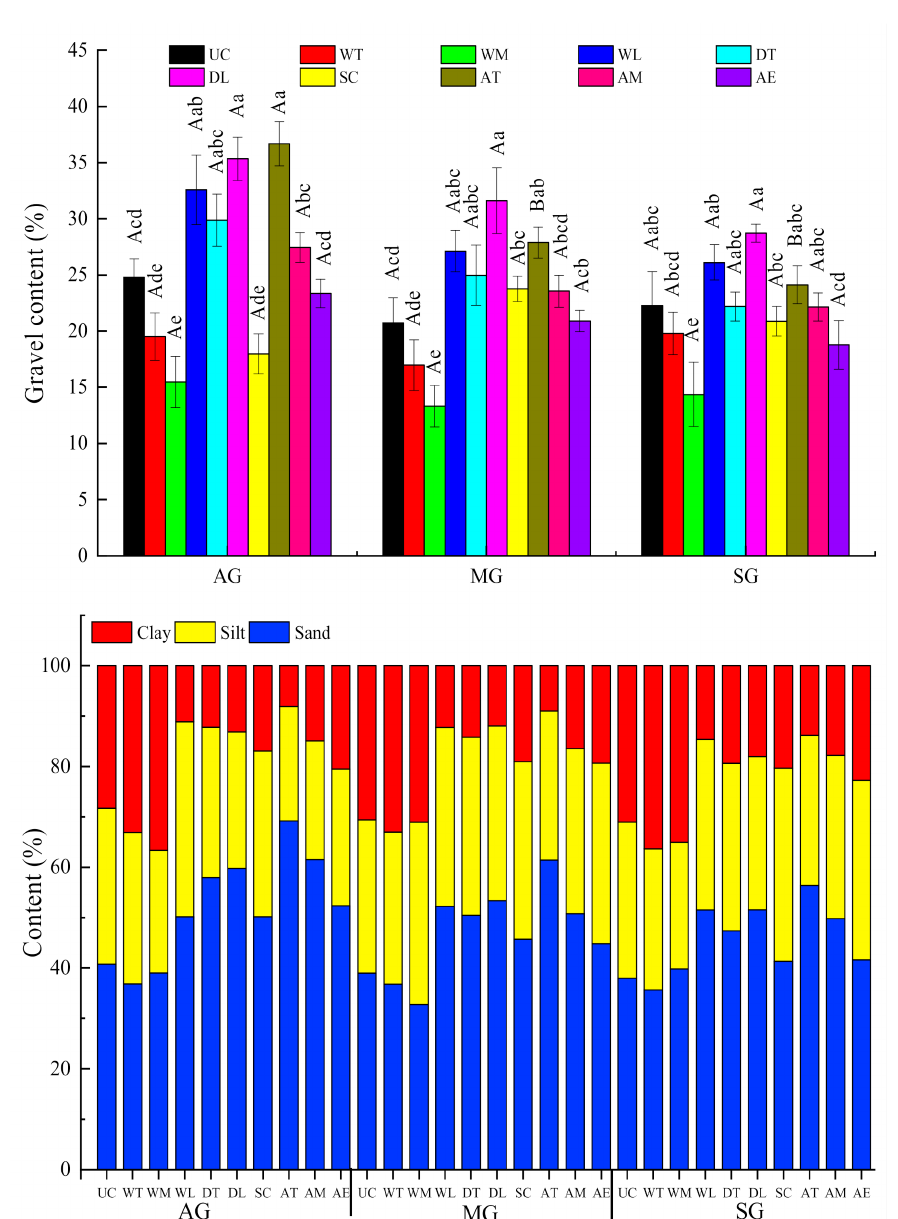
Figure 5. The content of gravel, sand, clay and silt in the different spatial positions in different stages of Benggang